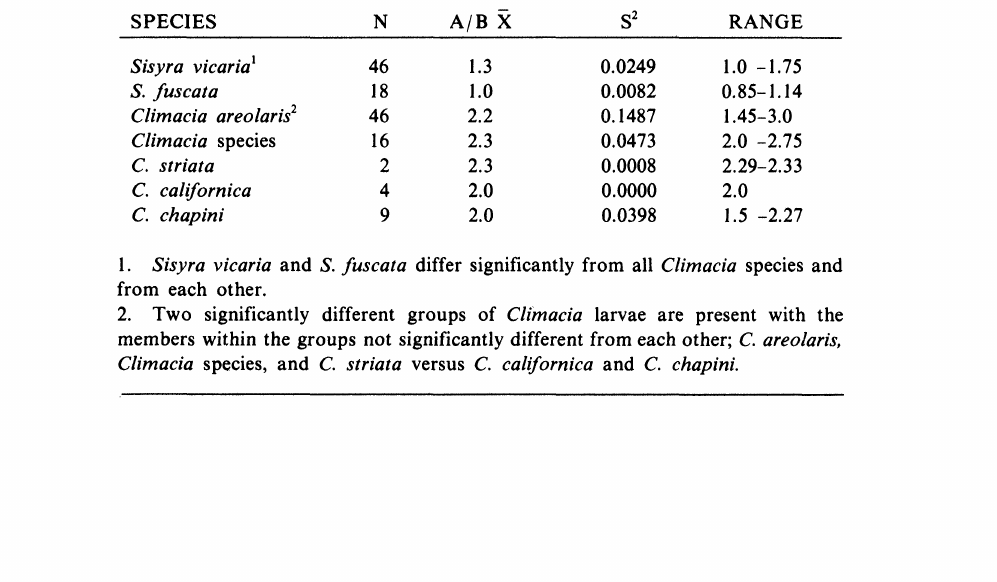
TABLE 1. Comparison of the ratio A/B obtained from the prothoracic tergites of seven sisyrid species (significance of differences between ratio values was analyzed using a modified T-test with alpha .05; N is composed of measurements from the right and left sides of individual